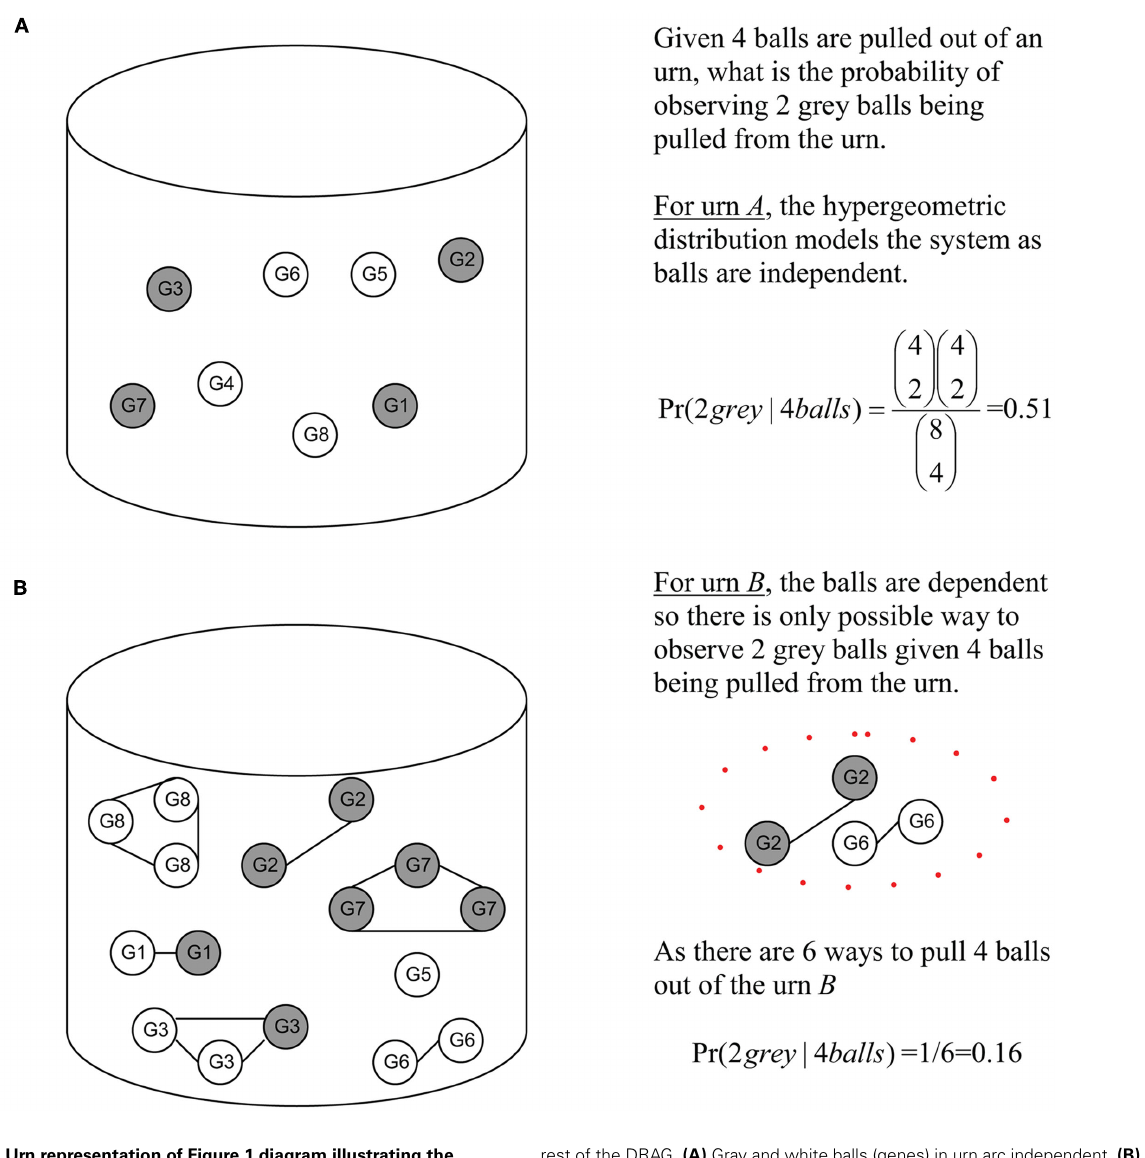
rest of the DRAG. (A) Gray and white balls (genes) in urn arc independent. (B) Gray and while (genes) in urn are interrelated, the GO DRAG and the scoring functions.The solid lines indicate that balls (genes) are